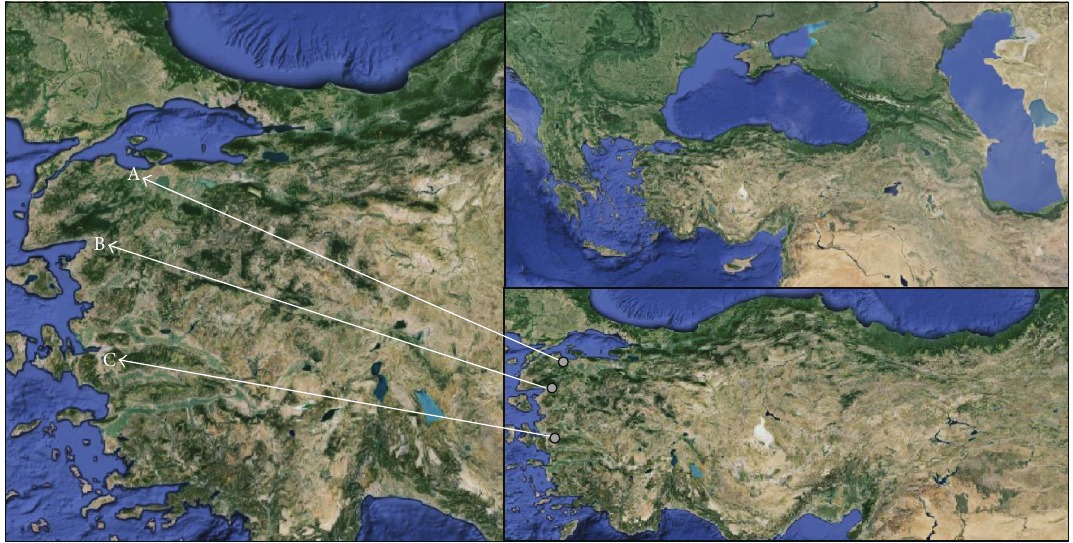
Figure 1: Harvesting locations of Olea europaea L. Edincik Su cv. fruits in Turkey: A: Edincik, B: Gomec, and C: Izmir.